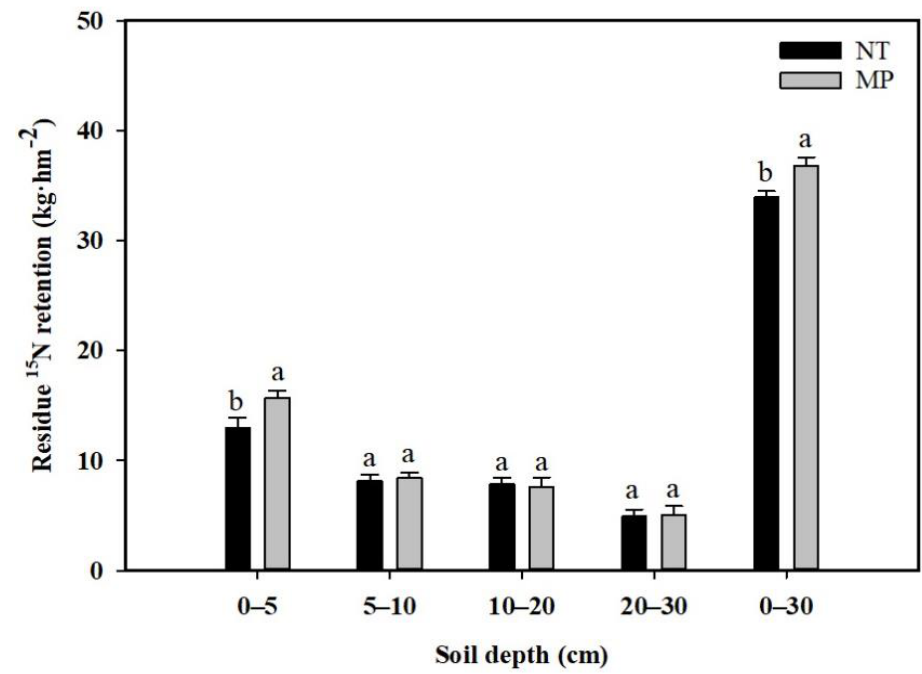
Figure 1. Distribution of residual 15 N fertilizer in the soil.